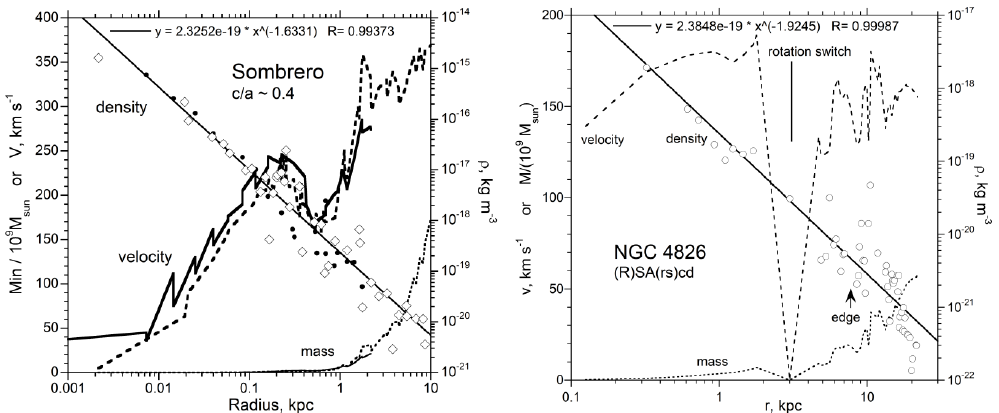
Figure 6. Inverse models of interesting spirals. Velocity and M in /(10 9 M Sun ) are both plotted on the left axis. ( left ) Sombrero galaxy, showing that disparities between RC measurements have little effect. Heavy solid line = RC of [71] was used to calculate M in (light solid) and ρ (open diamonds). Heavy broken lines = RC of [72] used to calculate mass (light broken line) and density (dots and fit). The visual edge is beyond the measurements; ( right ) Counter-rotating NGC-4826. RCs from deBlok et al. [54]. Results for mass and density are close to similar sized normally rotating NGC 7793 (Figure A3). We assumed that v = 0 at 4 kpc, midway between the nearest counter-rotating data points. The breadth of the v = 0 region affects the mass calculation, but little alters the density profile.